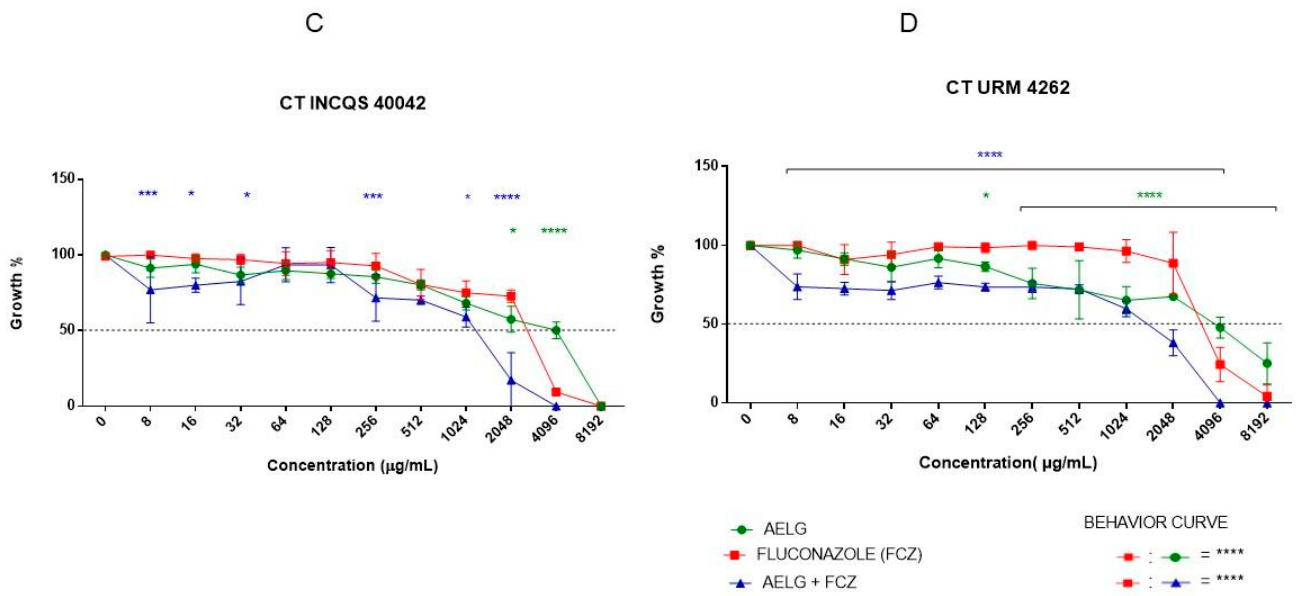
Figure 2. Cell viability curve of AELG alone and in combination with Fluconazole. Candida albicans INCQS 40006 ( A ), Candida albicans URM 4387 ( B ), Candida tropicalis INCQS 40042 ( C ) and Candida tropicalis URM 4262 ( D ). Statistical significance was determined considering the difference in relation to fluconazole, **** = p < 0.0001; *** = p < 0.001; ** = p < 0.01; * = p < 0.1. To evaluate the ability of the extracts to potentiate the antifungal activity of fluconazole,